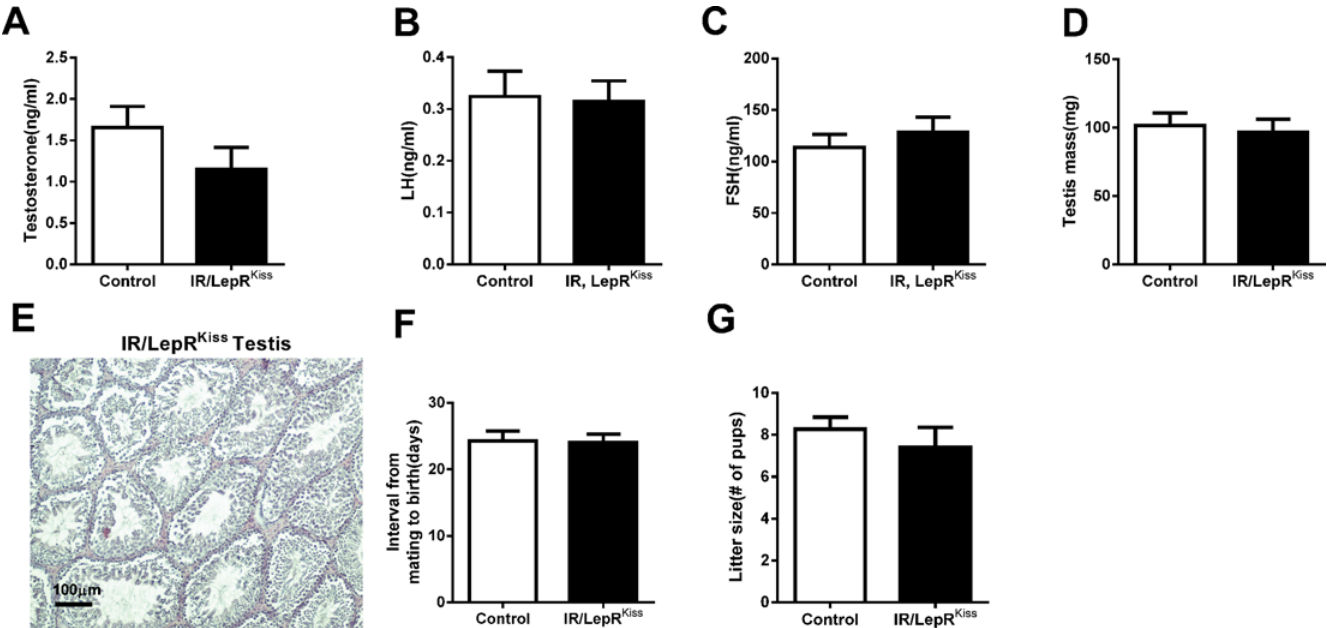
Fig 8. Male reproduction in IR/LepR Kiss mice. (A) Testosterone in adult males in control (n = 9) and IR/LepR Kiss (n = 8) mice. (B-C) LH and FSH levels in adult male control (n = 10 – 12) and IR/LepR Kiss (n = 10) mice. (D) Testis mass in control (n = 9) and IR/LepR Kiss (n = 8) mice. (E) Representative sections of adult testis in IR/LepR Kiss mice (n = 4). Scale bar, 100 μ m. (F-G) Fertility data from 5 – 6 months old males paired with established female breeders. Interval from mating to birth of a litter and litter size were compared between control (n = 12) and IR/LepR Kiss (n = 11) mice.